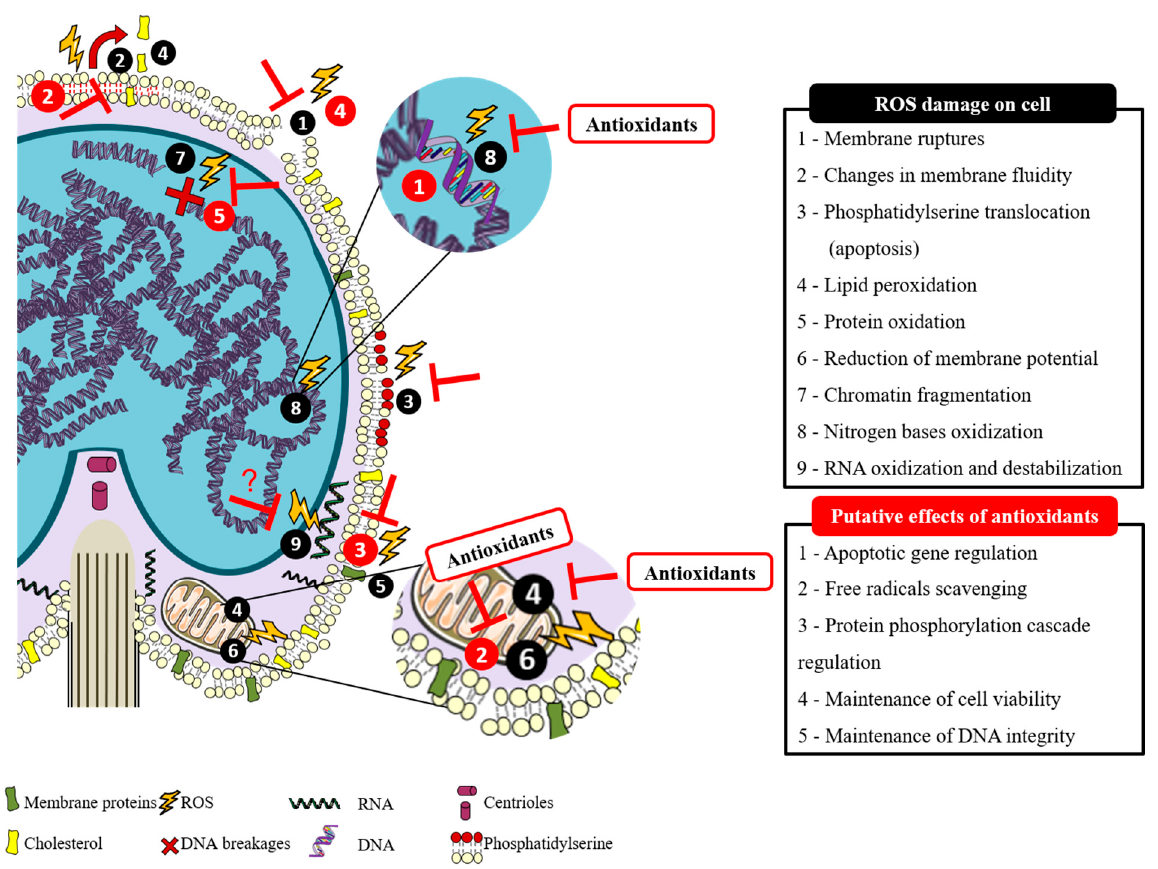
Figure 1. Putative effects of antioxidants on counteracting reactive oxygen species (ROS) damage in fish sperm. Adapted from Cabrita, et al. [1].